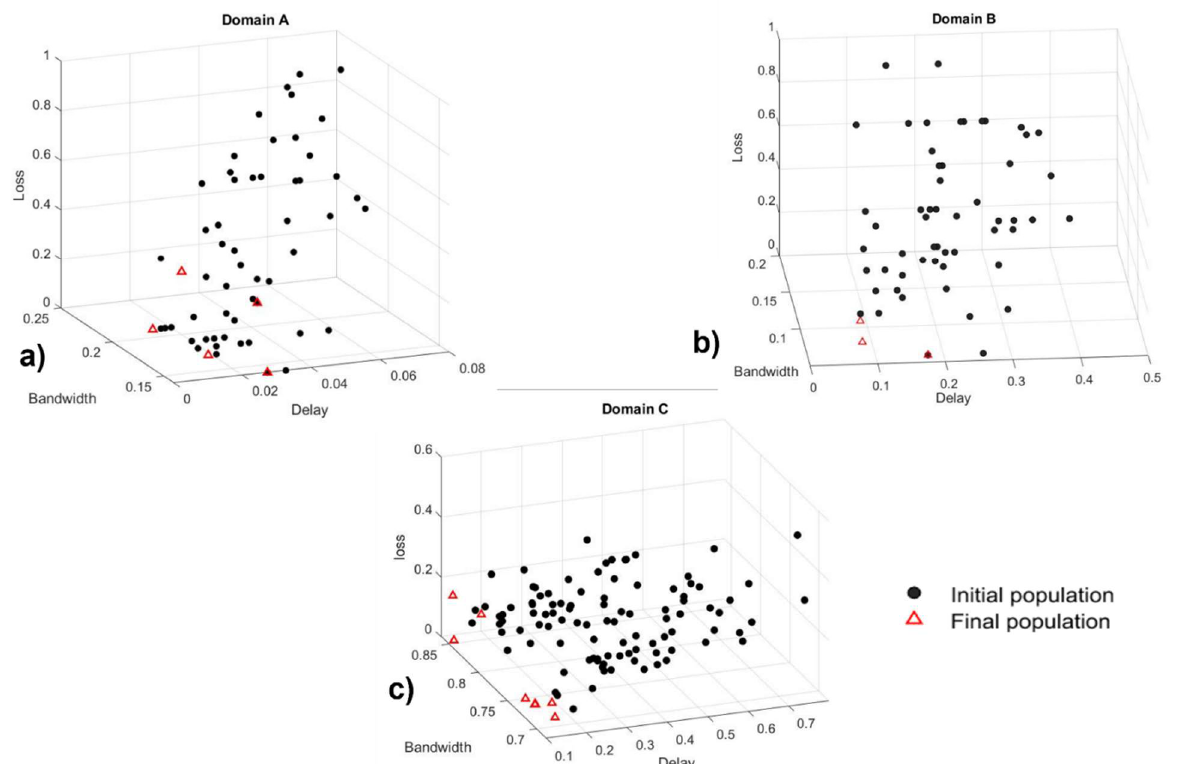
Figure 7. Set of non-dominated solutions obtained by the multi-objective cellular genetic algorithm MOCell. ( a ) Domain A, ( b ) Domain B, and ( c ) Domain C.